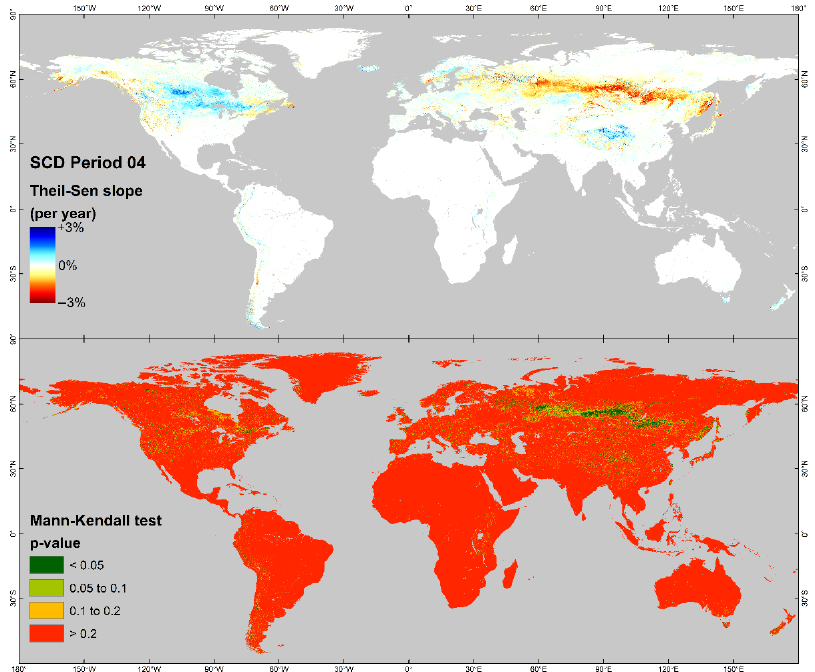
Figure 7. Pixel-based development of SCD in April. The Theil–Sen slope is shown above and the associated p -values are shown below.